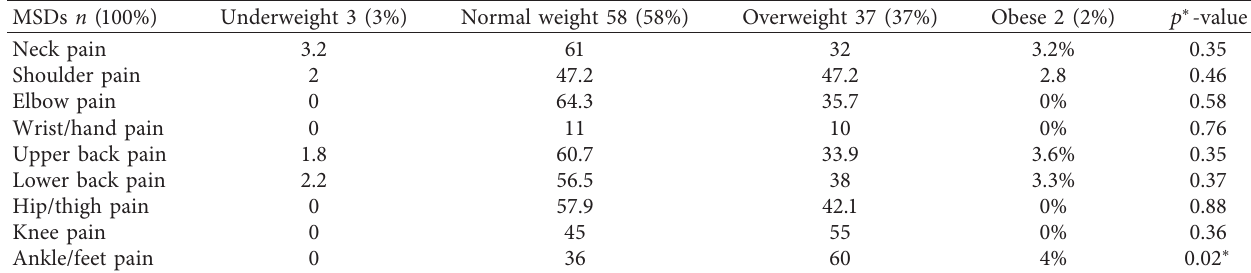
Table 3: Association of BMI related to MSDs.